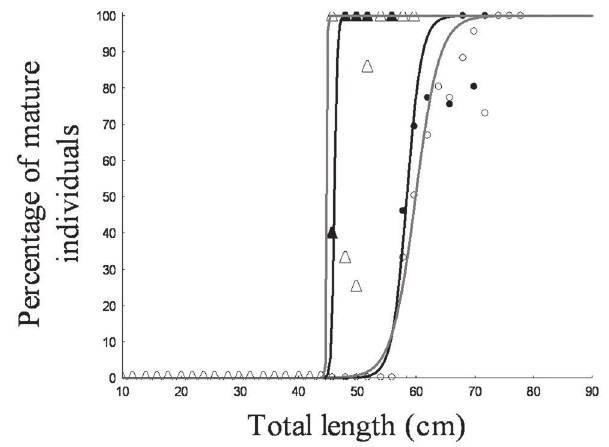
Fig. 4. Percentage of mature individuals by total length class for males and females Sympterygia acuta (black line) and S. bonapartii (grey line). Empty triangles represent male Sympterygia bonapartii and full triangles, male S. acuta. Empty circles represent female S. bonapartii and full circles, female S. acuta